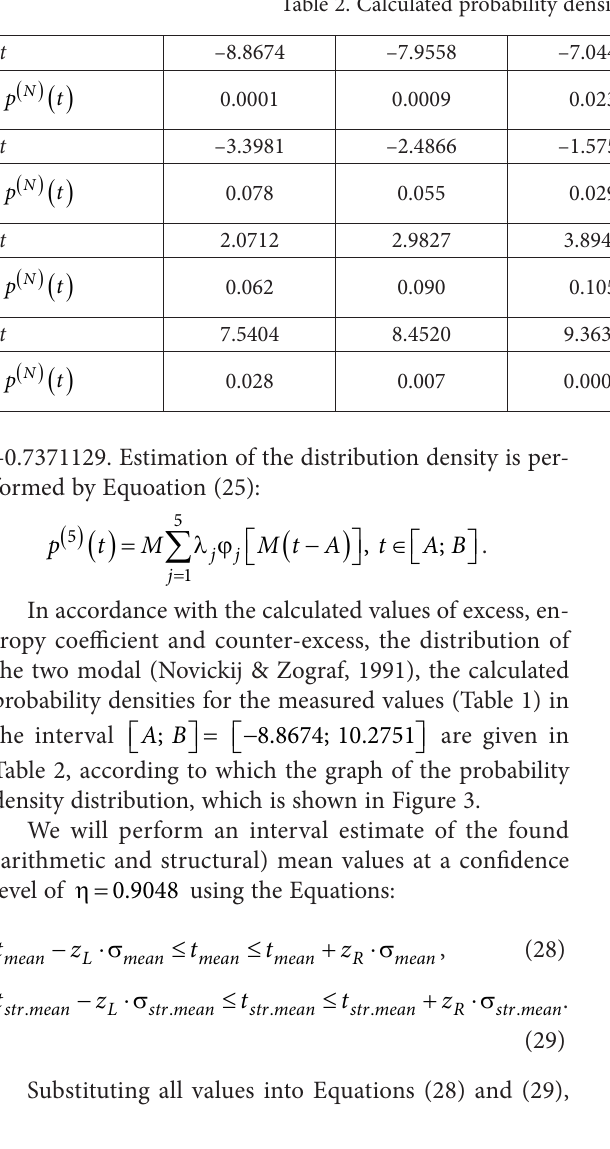
Table 2. Calculated probability densities using the program DensProb